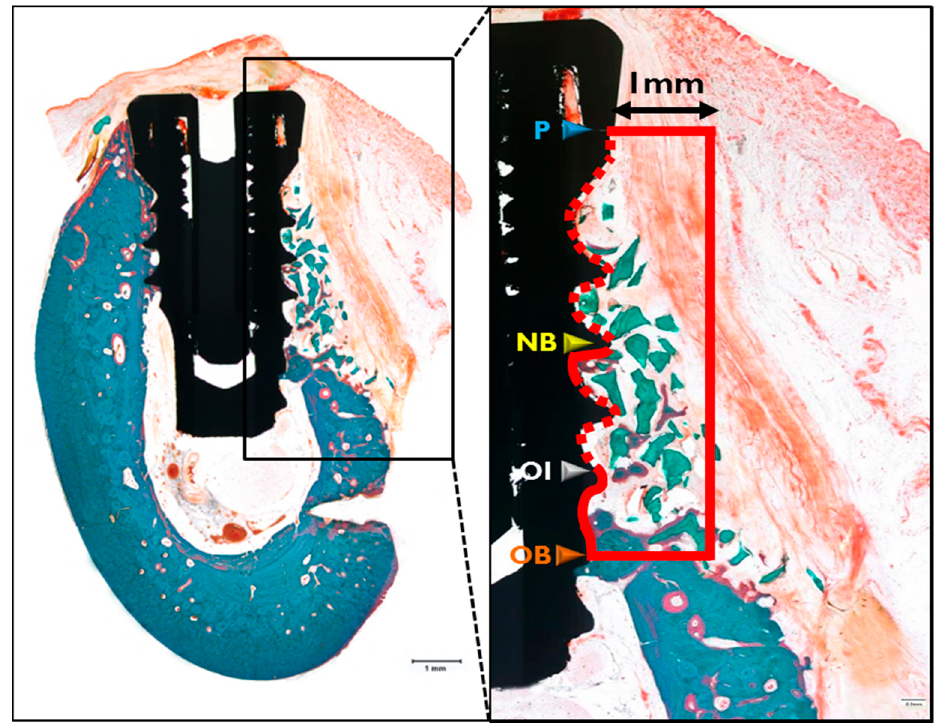
Figure 15. Parameters measured in histologic specimens. Red box, the area of interest (AOI was 1 mm wide and 1 mm high from the implant platform to the uppermost point of old bone (P-OB)); Blue arrow, platform of the implant (P); Yellow arrow, the uppermost point of new bone (NB); White arrow, uppermost point of the osseointegration site (OI); Orange arrow, uppermost point of old bone (OB) in the AOI.